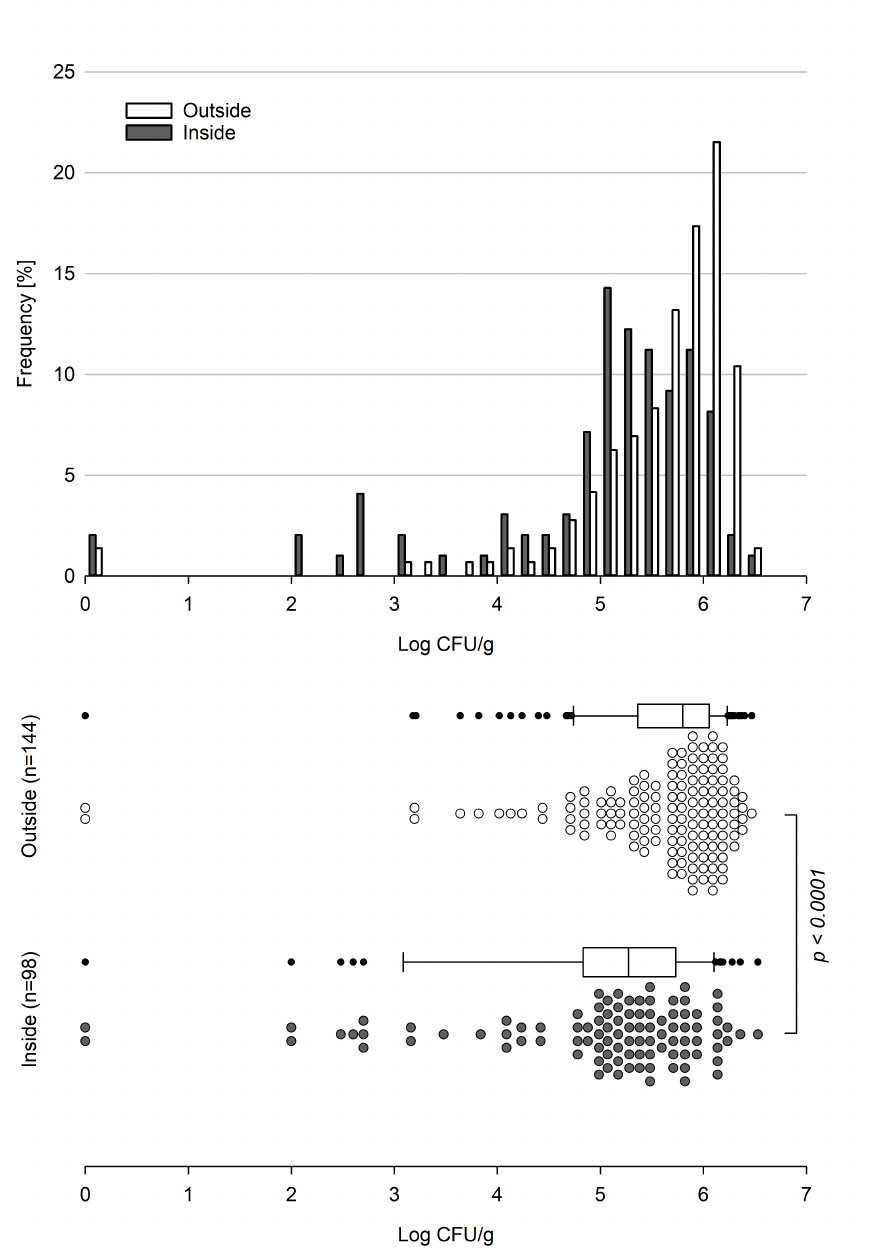
Figure 1. Frequency and range of viable Basidiobolus spp. counts obtained over 3.5 years in gecko drop- pings collected from inside and outside locations. The p -value was calculated using the Wilcoxon— Mann—Whitney